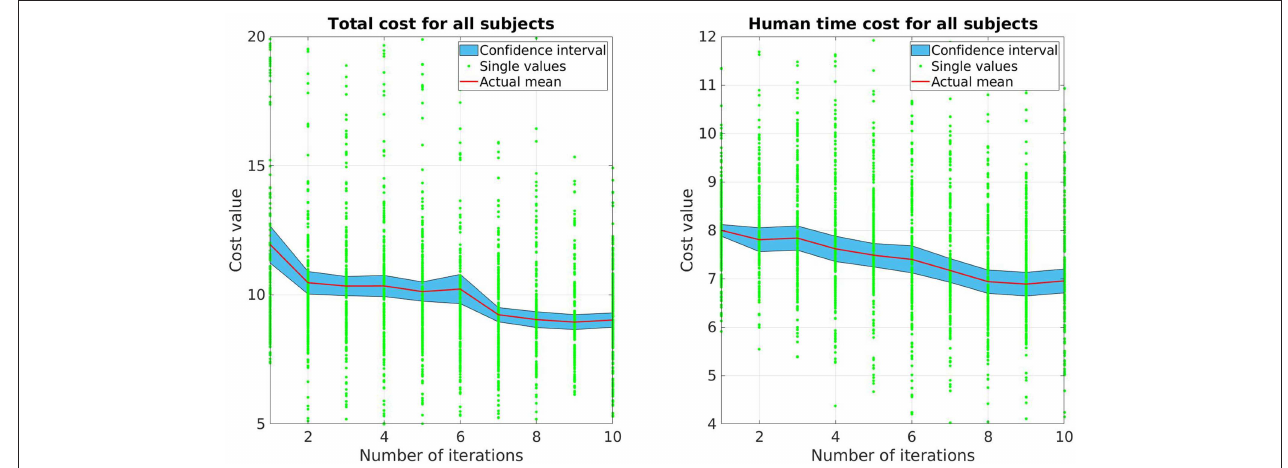
FIGURE 3 | The mean and confidence interval of the total cost and human prediction time cost for all